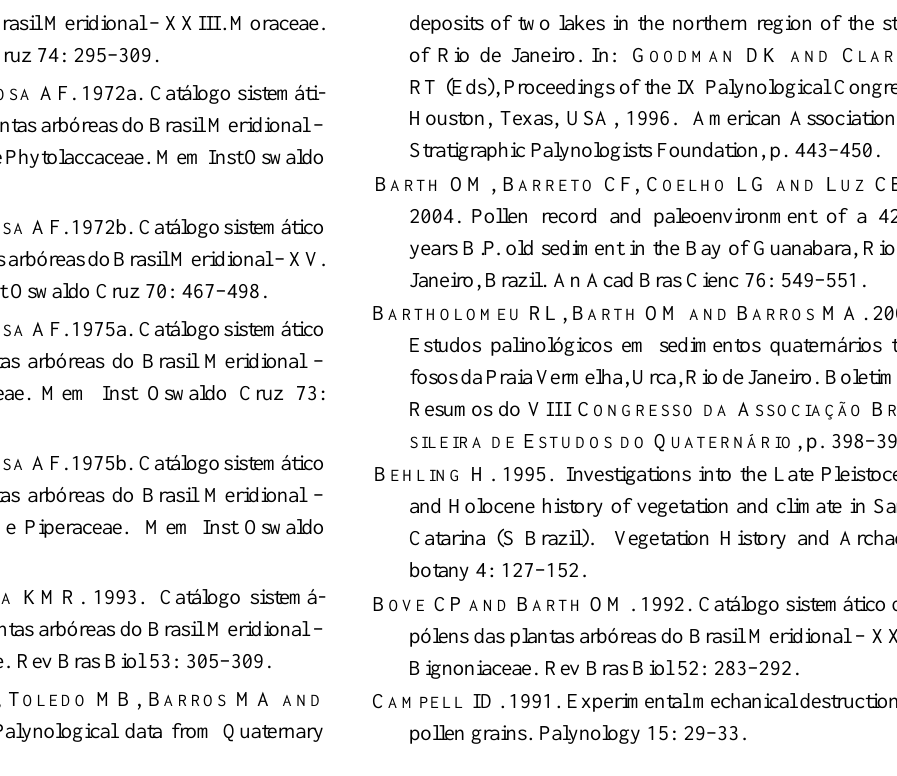
plantas arbóreas do Brasil Meridional – XXIII.